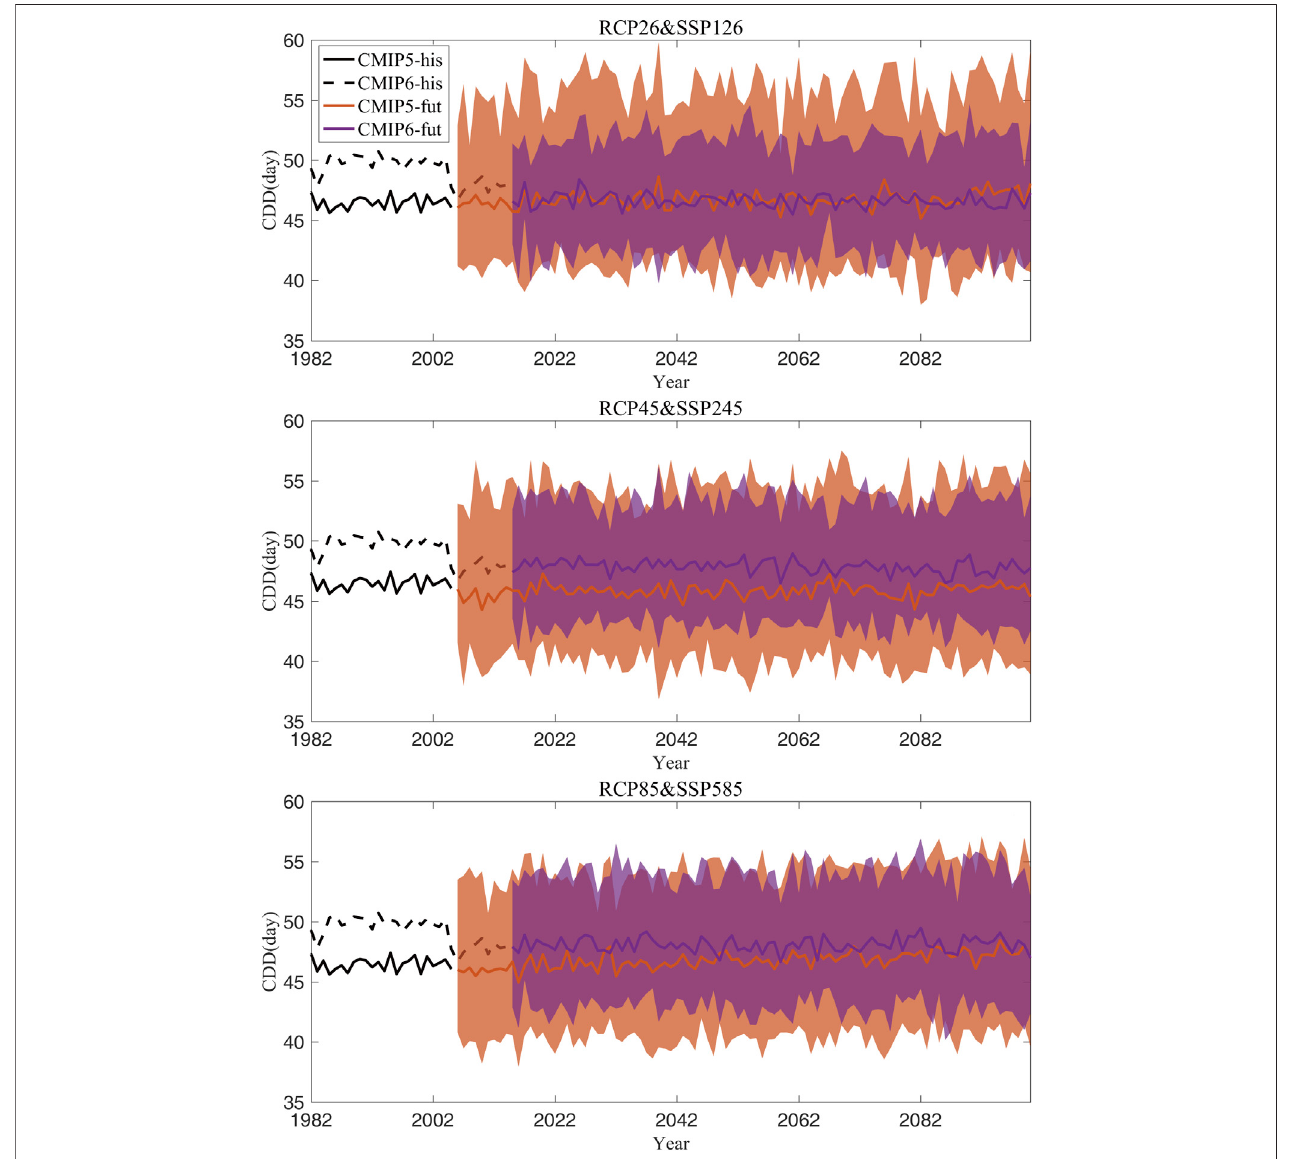
FIGURE 15 | Global land-average multi-model mean CDD during 1982 – 2100 in CMIP5 and CMIP6. The shaded region shows the uncertainty range (between the 25 quantiles and the 75 quantiles).